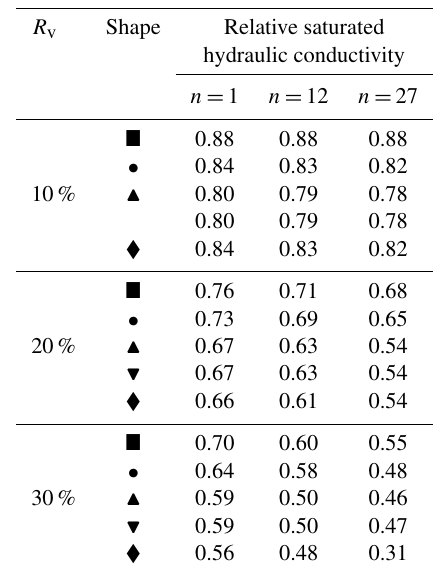
Table 3. Results from the investigation of the inclusion size and shape with regard to the saturated hydraulic conductivity by means of numerical simulations ( n is the number of inclusions simulated in the profile for the corresponding R v